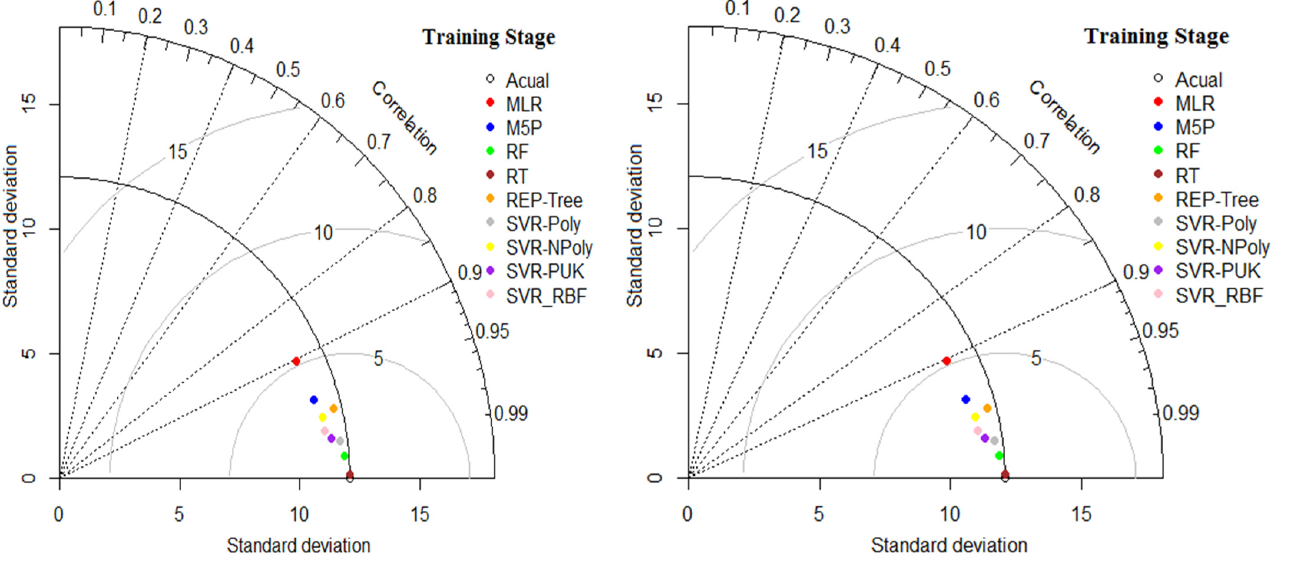
Figure 5. Taylor diagram for all applied models.